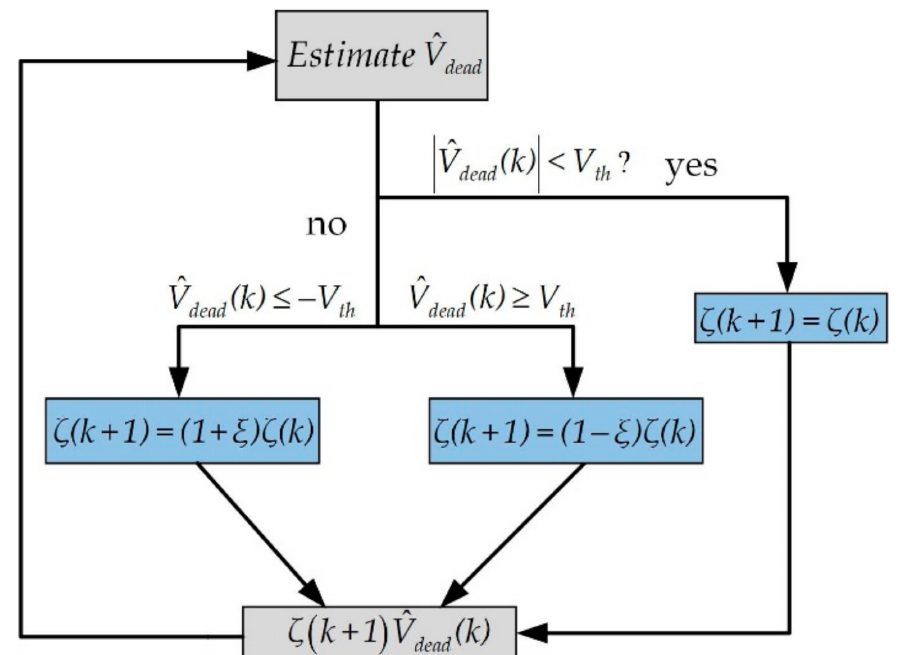
Figure A2. Online tuning of V dead compensation